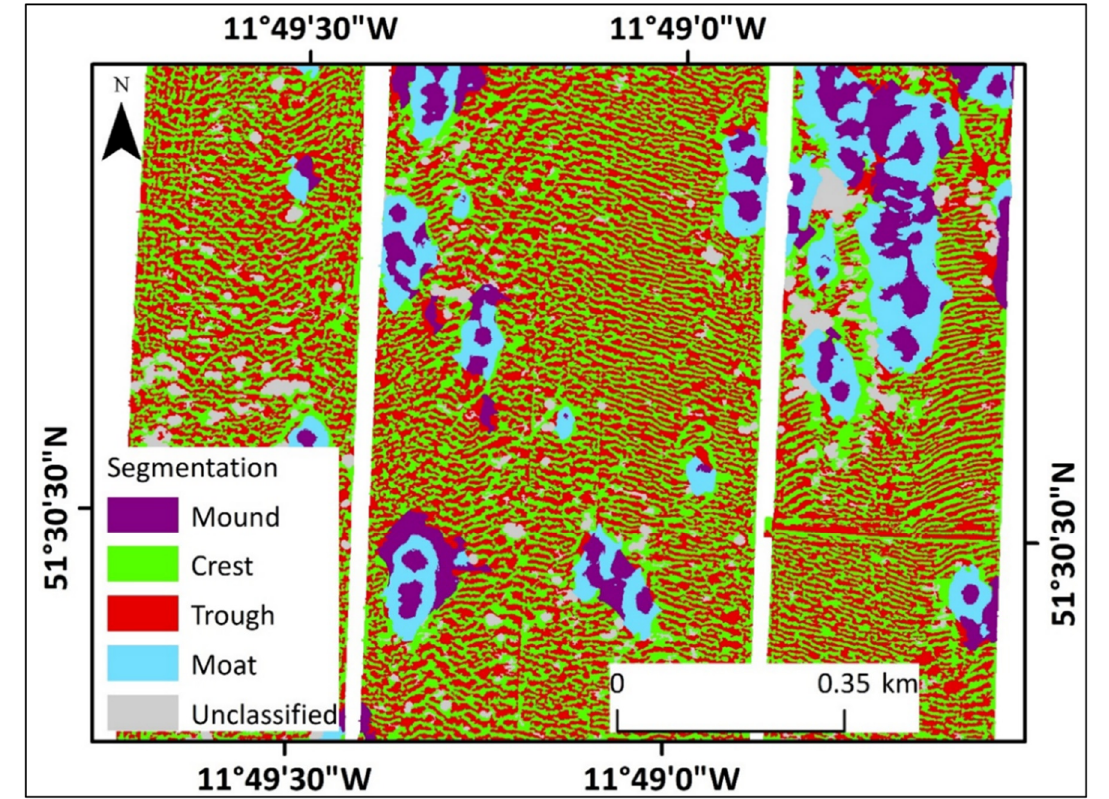
Figure 4. Displaying the multi-scale morphological characterisation output with the larger scale coral mound features—the “mounds” and “moats”—and the lower scale features—the “crests” and “troughs”.